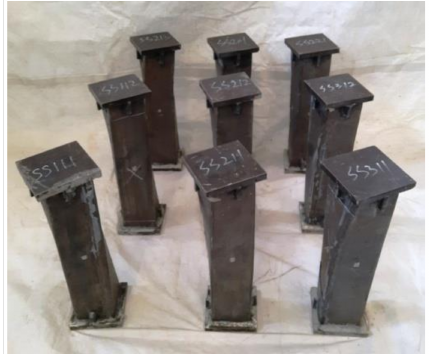
Figure 6. Square section specimen after flexural-torsional